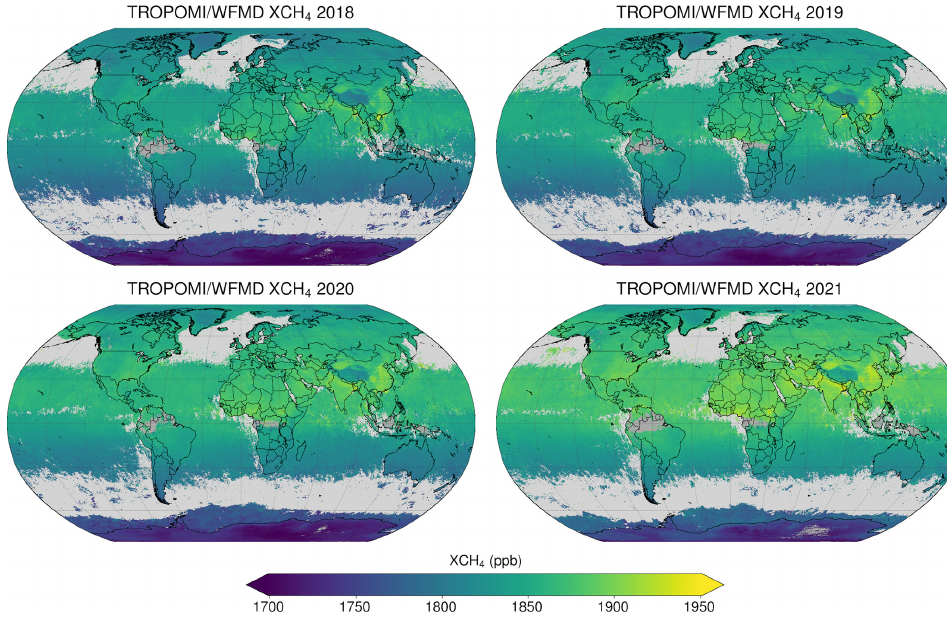
Figure 19. Yearly averages of TROPOMI/WFMD v1.8 XCH 4 shown on a 0 . 1 ◦ × 0 . 1 ◦ grid.